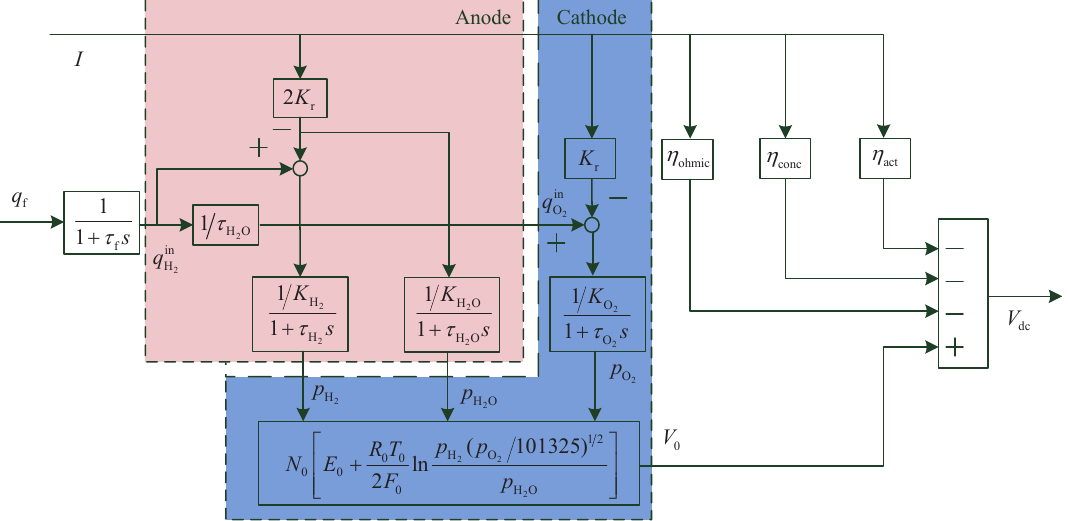
Figure 2. SOFC system dynamic